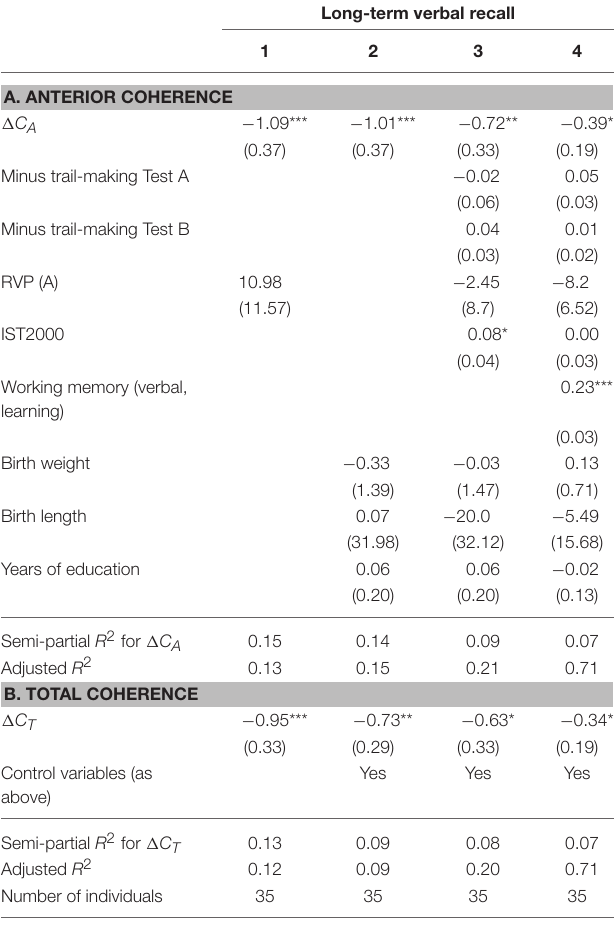
TABLE 4 | Linear regression of long-term memory and 1 C —alternative control variables.